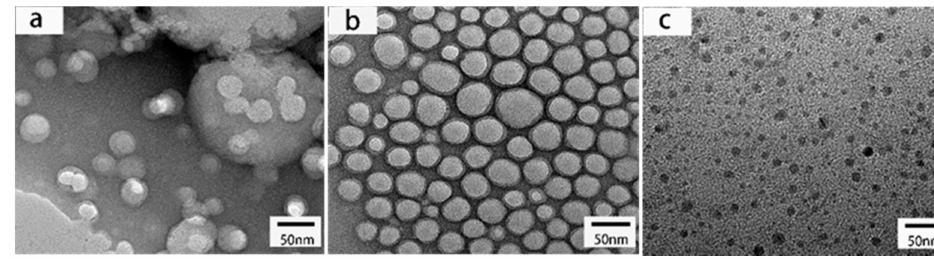
Figure 4. TEM micrographs of ( a ) CO 0% –WPU, ( b ) CO 5.04% –WPU and ( c ) CO 9.66%